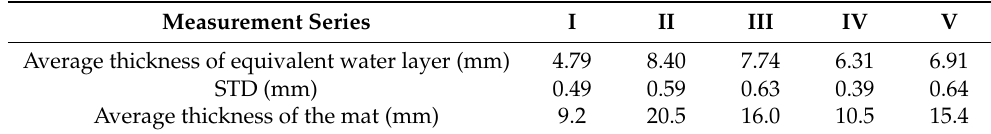
Table 1. Average thickness of the equivalent water layer with corresponding standard deviation (STD) and the average thickness of the mat for the measurement series I–V.